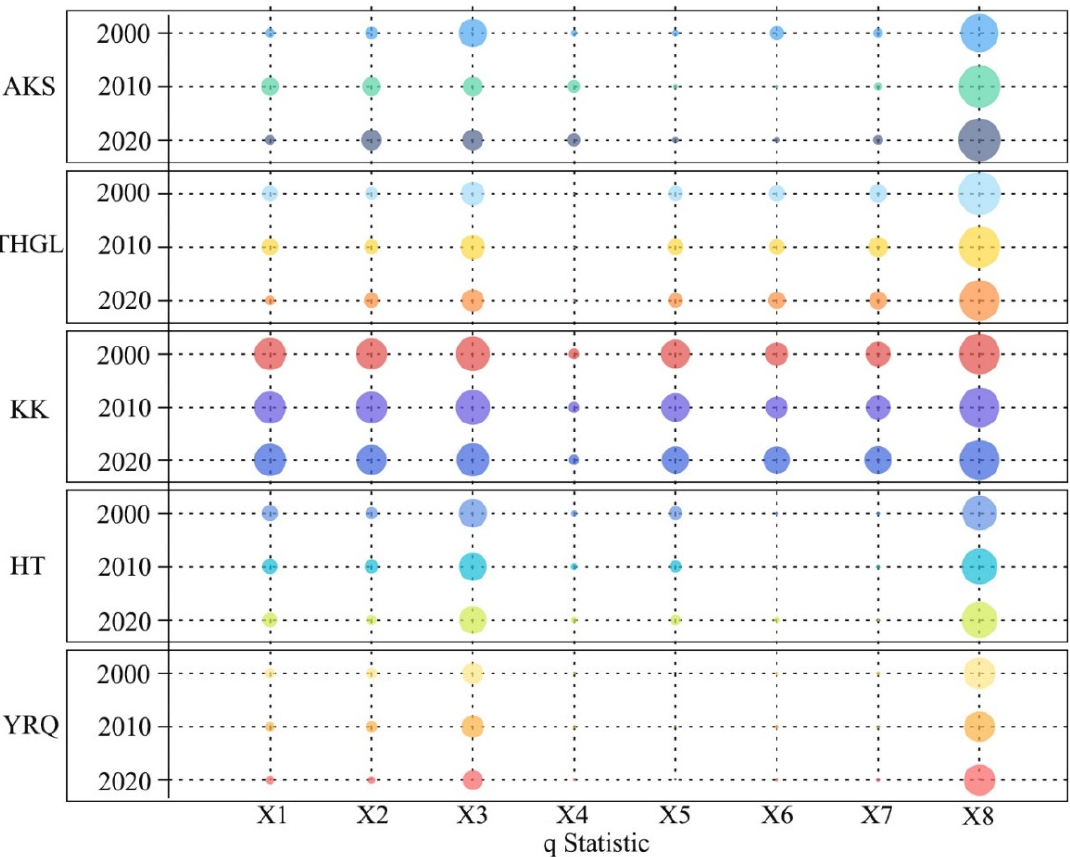
Figure 7. Factor detection of ESV spatial differentiation.